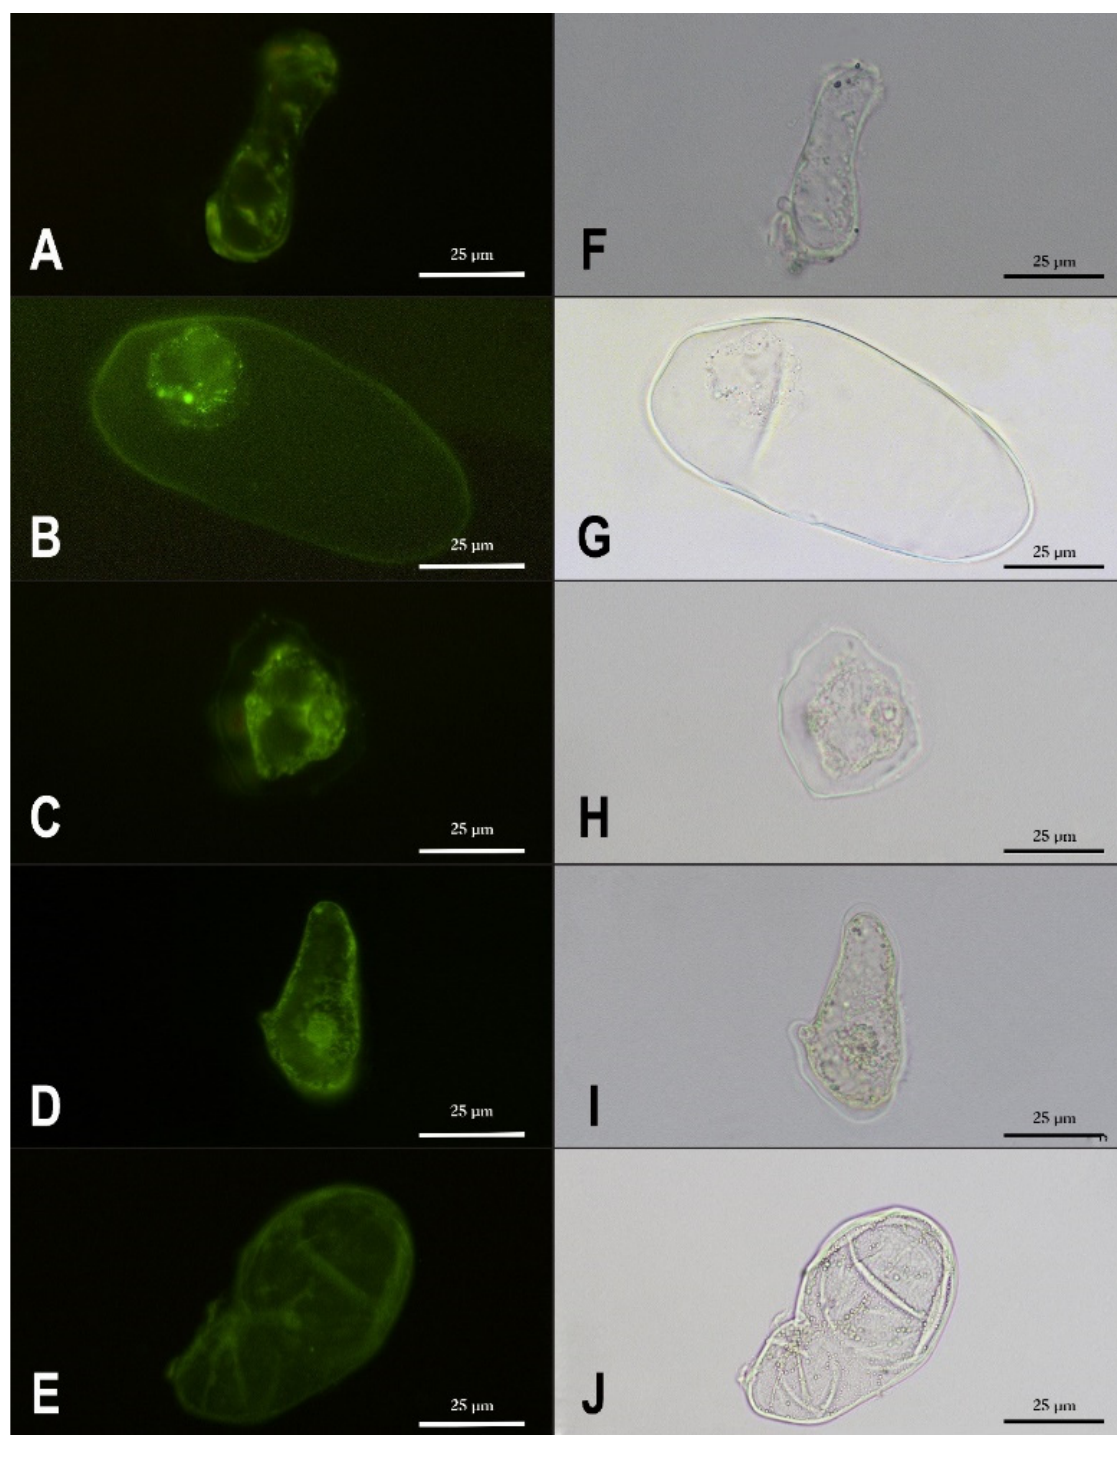
Figure 4. Intracellular lead detection after exposure to 200 µ M of Pb using Leadmium Green staining. Left column: fluorescence microscopy; right column: light microscopy; Arabidopsis thaliana ( A , F ), Silene vulgaris subsp. humilis ( B , G ), Viola x wittrockiana ( C , H ), V. tricolor ( D , I ), and V. philippica ( E , J ).